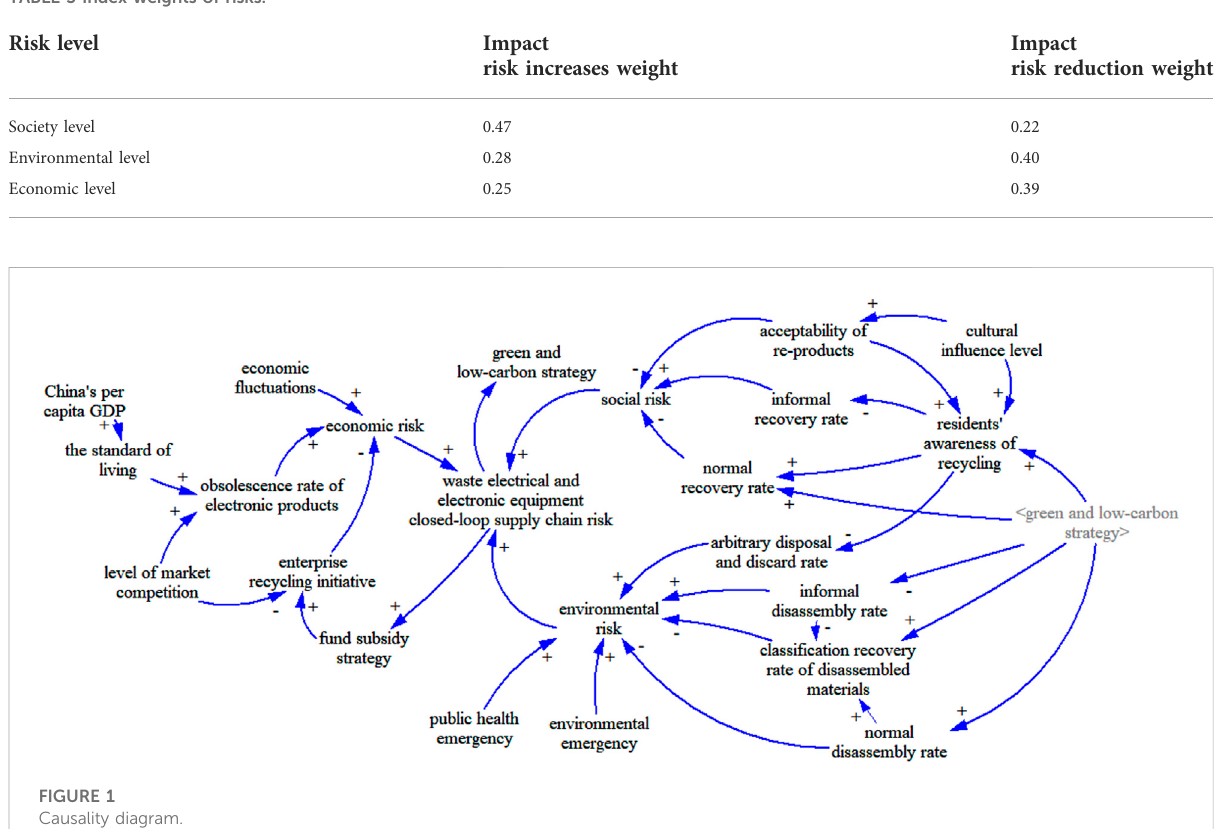
FIGURE 1 Causality